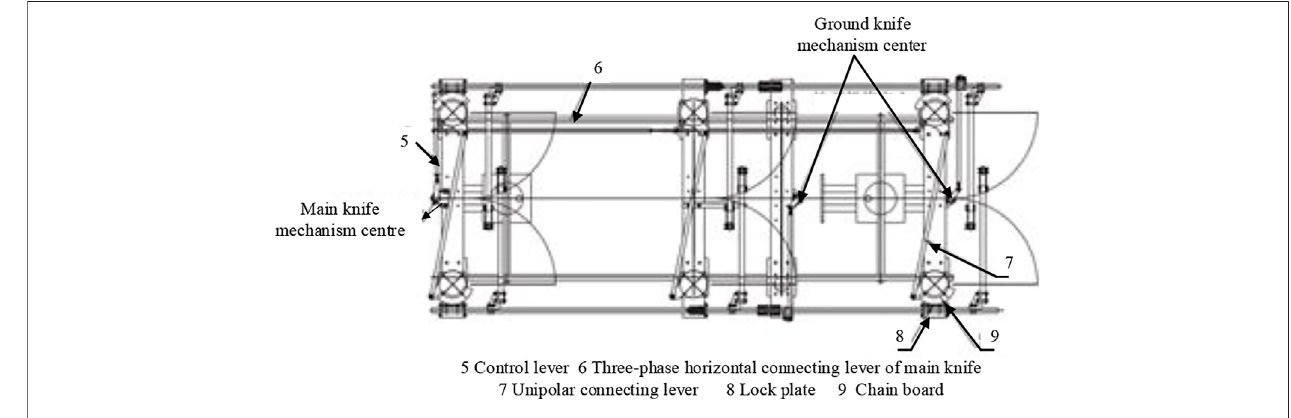
FIGURE 6 | The GW4D-126 model diagram.